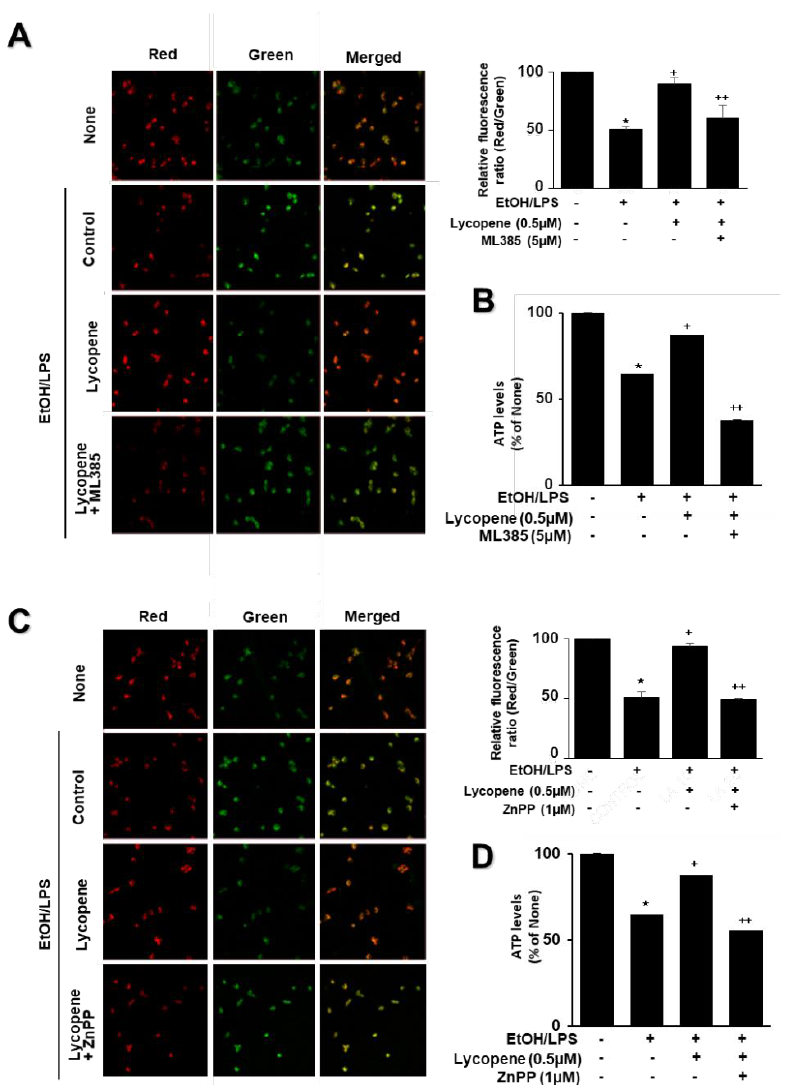
Figure 7. Effect of ML385 and ZnPP on mitochondrial dysfunction in ethanol (EtOH)/lipopolysaccharide (LPS)-stimulated and lycopene-treated AR42J cells. Cells (2 × 10 5 /2 mL/well) were pretreated with ML385 (5 µ M) or ZnPP (1 µ M) in the presence of lycopene (0.5 µ M) for 1 h and stimulated with EtOH (at a final concentration of 250 mM)/LPS (10 µ g/mL) for 30 min. ( A , C ) The cells were stained with JC-1 dye and visualized with a confocal laser scanning microscope (left panel). The MMP was determined by measuring the intensity of red emission relative to the intensity of green emission (right panel). A decrease in the red/green fluorescence intensity ratio indicates mitochondrial depolarization. Data are expressed as the mean ± SE ( n = 3 in each group). ( B , D ) ATP levels were quantified using luminescent ATP substrate. The ATP concentration was determined by interpolating within the ATP standard reference. The fluorescence ratio and/or ATP level in control cells (cells treated without EtOH/LPS, lycopene, ML385, and ZnPP) was set as 100%. Data are expressed as the mean ± SE ( n = 12 in each group). * p < 0.05 vs. control cells (cells without EtOH/LPS stimulation and without any treatment); + p < 0.05 vs. cells with EtOH/LPS stimulation and without any treatment;. ++ p < 0.05 vs. cells with EtOH/LPS stimulation and lycopene treatment. The cells incubated with tetrahydrofuran (THF, 0.01%) alone served as a vehicle control. For each experiment, lycopene- untreated cells received a vehicle THF (0.01%) alone instead of lycopene. ML385 and ZnPP were dissolved in dimethyl sulfoxide (DMSO). For each experiment, ML385- or ZnPP-untreated cells received a vehicle DMSO (0.05%). +,